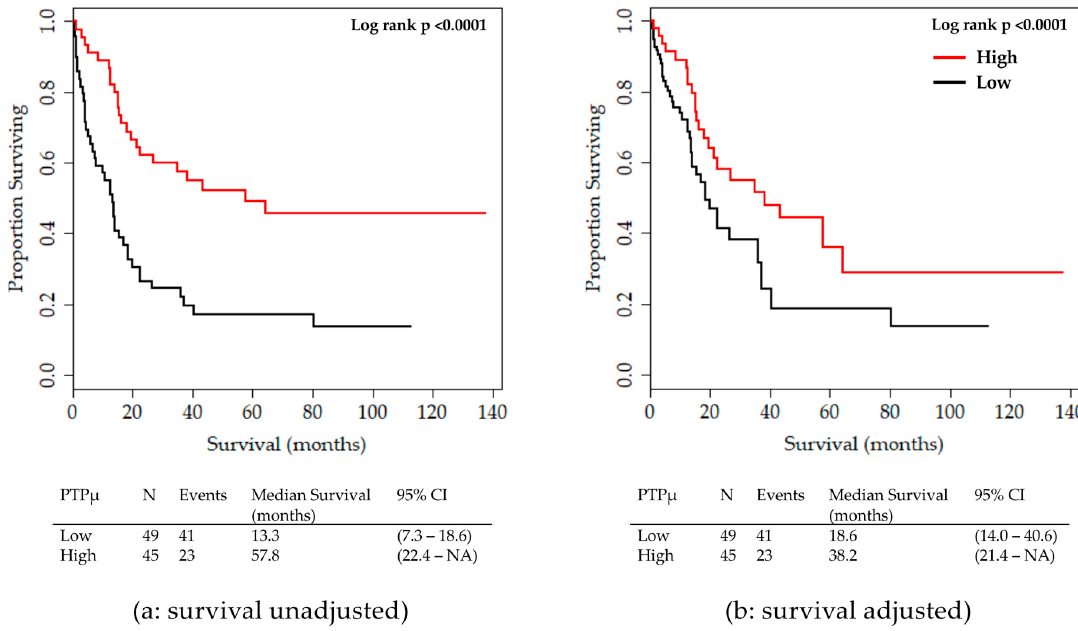
Figure 2. Kaplan Meier Plot for overall survival by PTP μ high versus low staining for all glioma patients. ( a ) Unadjusted overall survival. ( b ) Overall survival adjusted by sex, tumor grade, age group, and IDH1 mutation status. Median survival with 95% Confidence Intervals for each group are shown below each plot.